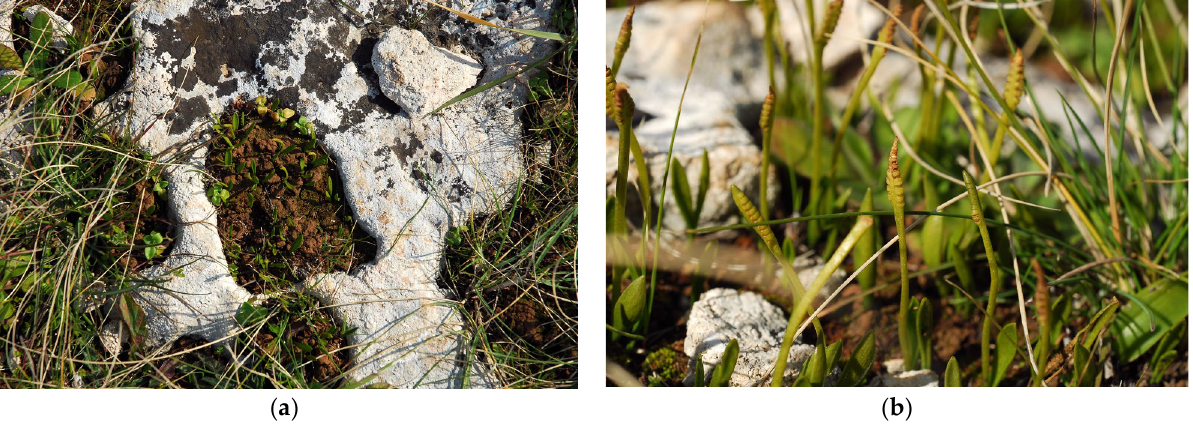
Figure 1. ( a ) Small patches of soil with O. lusitanicum community; ( b ) Individuals of O. lusitanicum in late winter. Locality: Polignano a Mare (Bari). Date: 4 March 2012. Photos by Enrico Vito Perrino.